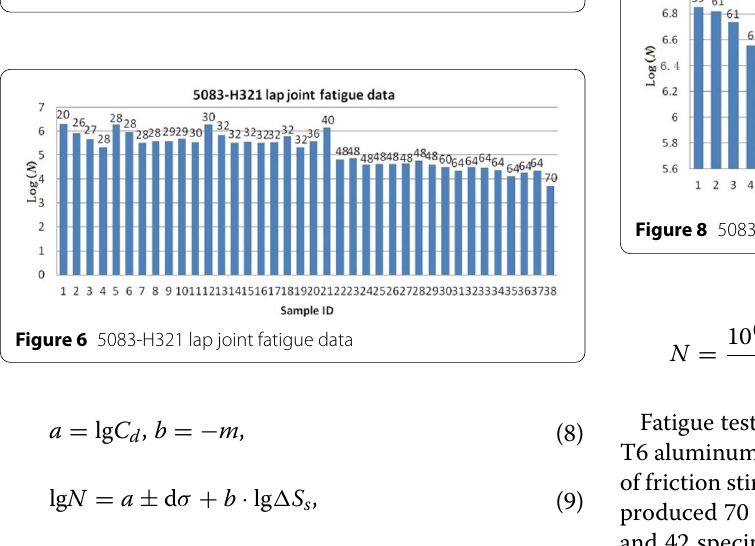
Figure 5 Absolute displacement versus stop time of test